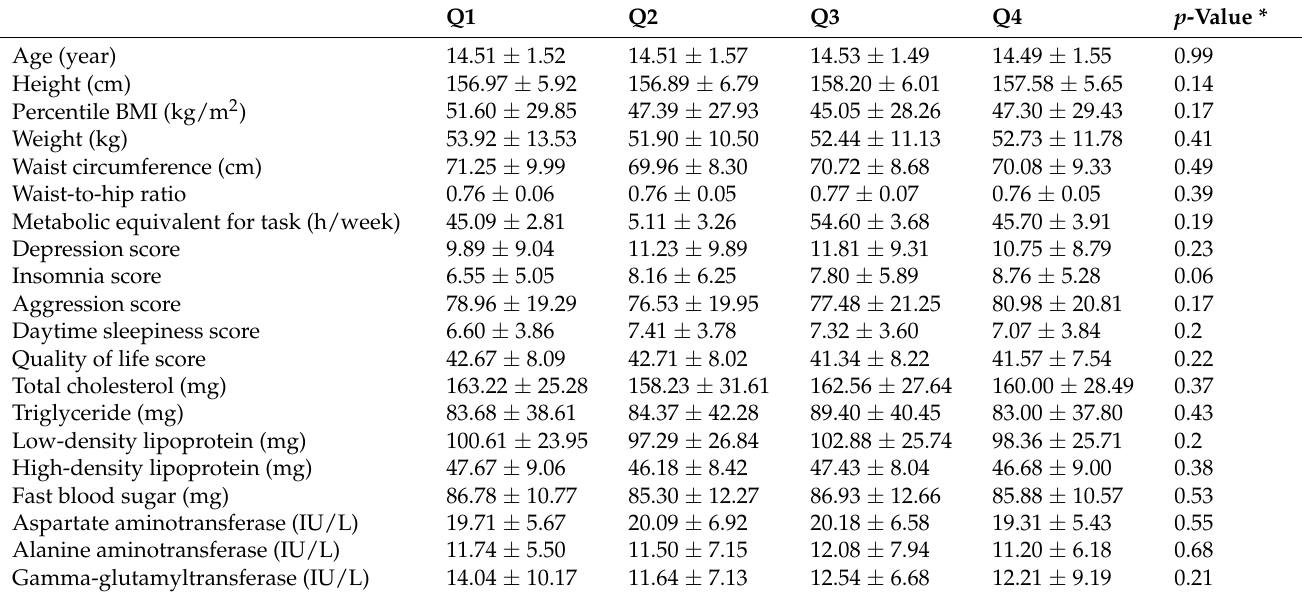
Table 1. General characteristics of the study participants by quartile of ultra-processed food intake.